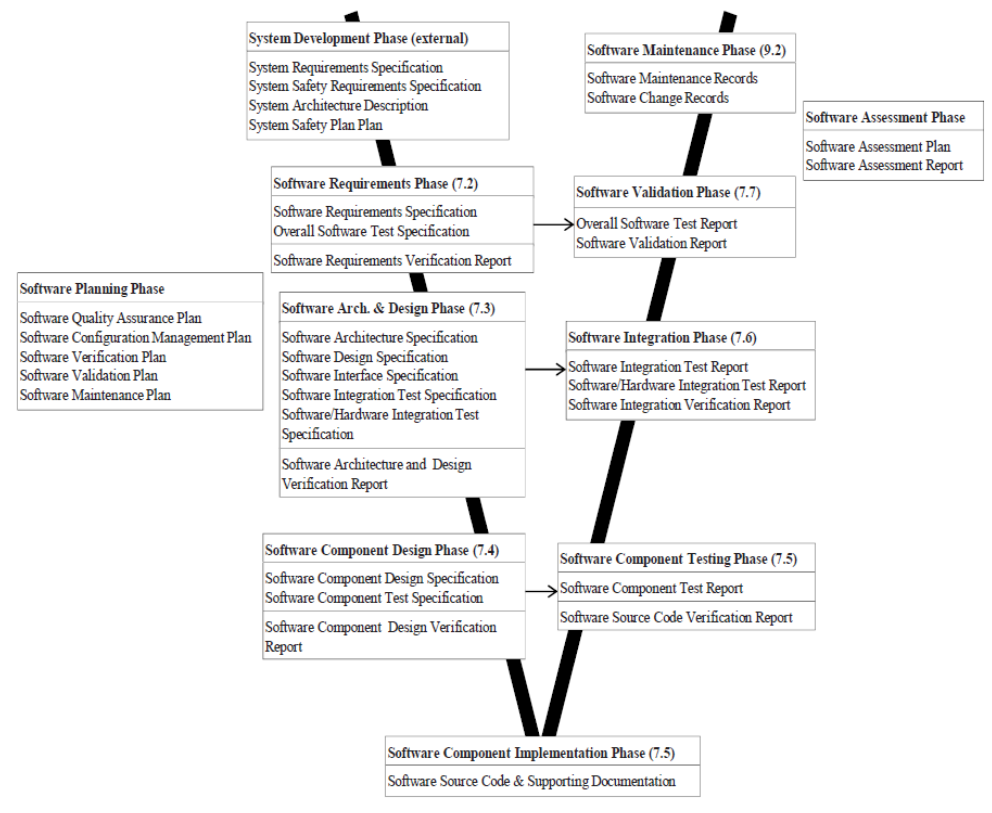
Fig. 1. Software development life cycle in